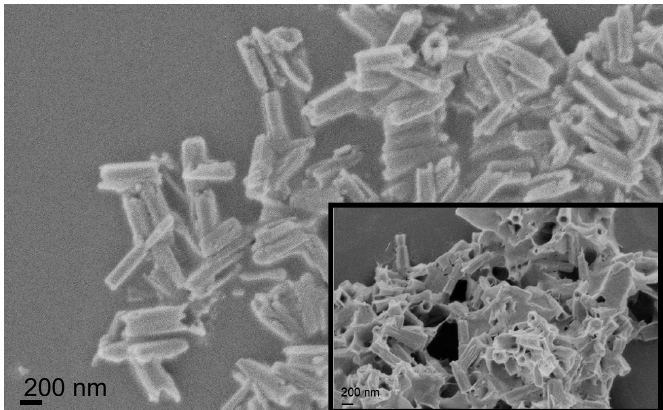
Figure 1. Field emission scanning electron microscopy (FESEM) image of zinc oxide nanorods (ZnO Nrods).